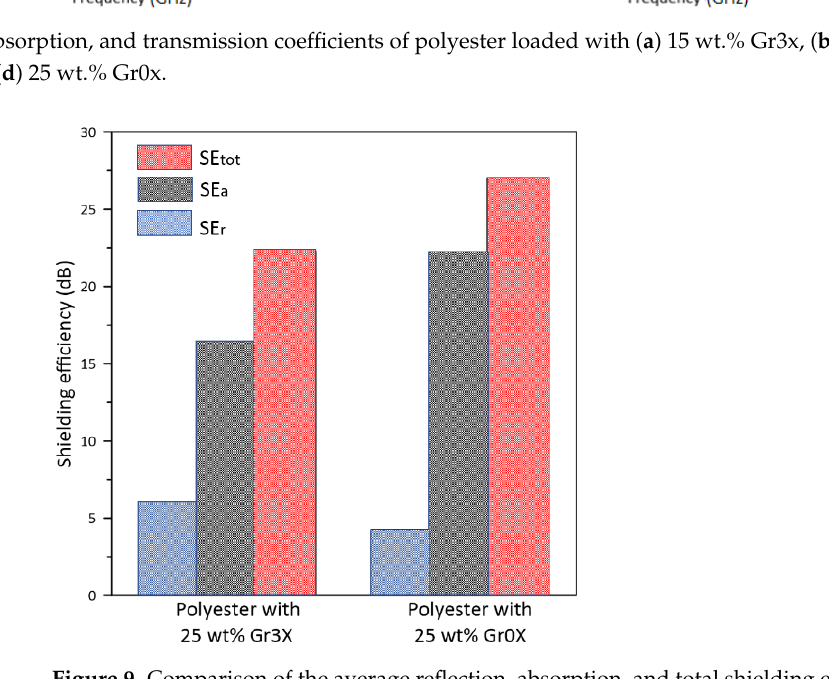
Figure 9. Comparison of the average reflection, absorption, and total shielding efficiency of polyester with 25 wt.% Gr3x versus 25 wt.% Gr0x in the X-band frequency range.